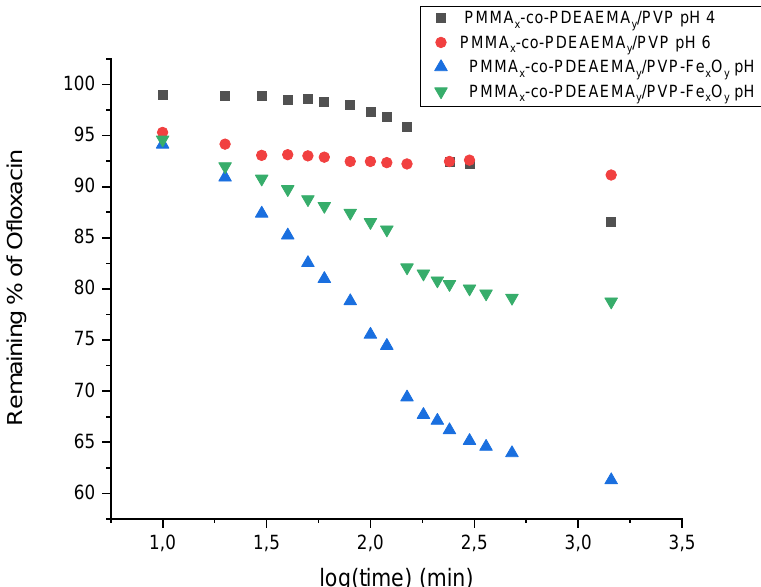
Figure 12. Adsorption kinetic plots for OFL removal recorded in the presence of the pristine (PMMA x -co-PDEAEMA y /PVP) and magnetoactive (PMMA x -co-PDEAEMA y /PVP-Fe x O y ) crosslinked electrospun fibrous membranes at pH 4 and 6.